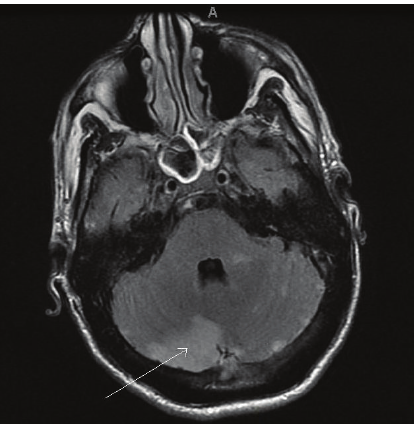
Figure 5: MRI brain with and without contrast revealing multiple foci of predominantly cortical signal change with the largest area involving the medial right cerebellar hemisphere (white arrow). The appearance is most compatible with subacute infarcts, presumably from an embolic source. There are no enhancing masses to suggest metastatic